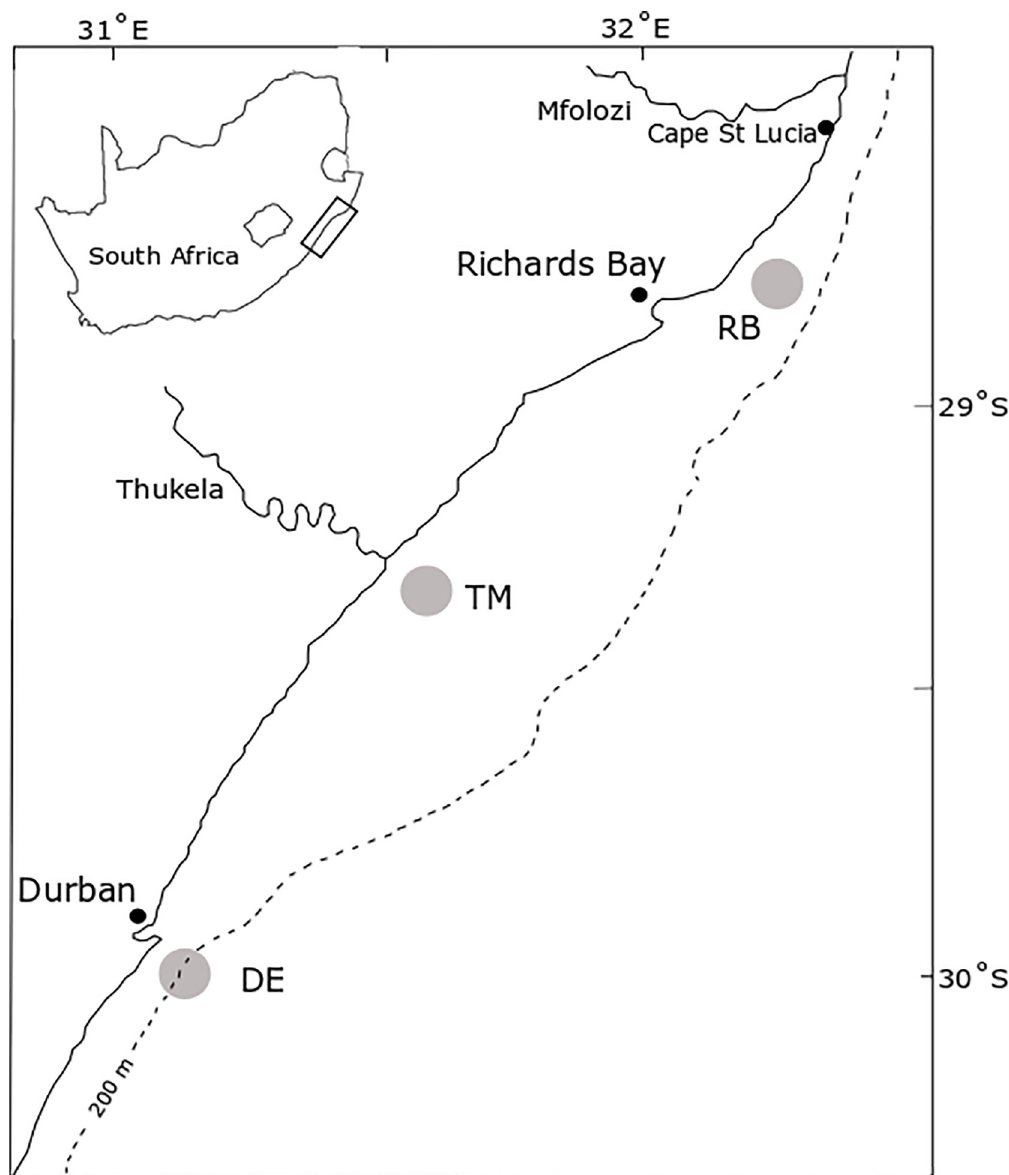
Fig 1. The KwaZulu-Natal Bight and location of subsystems. DE: Durban Eddy, TM: Thukela Mouth, RB: Richards Bay. of production utilised in the system. If one of either B, P/B, Q/B or EE is unknown, it is esti- mated using two mass-balance equations which ensure the inflows into each group in the sys- tem are equal to its outflows [52]. Nitrogen and phosphorus networks were constructed using data from carbon networks and C:N, C:P and N:P ratios from [40] or literature (see 2.3 Data Sources). From these stoichiometric, mass-balanced networks, nutrient transfer efficiencies and recycling, nutrient limitations for nodes and limiting flows were calculated (see 2.4 Net- work Analysis Methodology), to illustrate differences and similarities in the three subsections of the KZN Bight, and link them to influences of adjacent ecosystems.